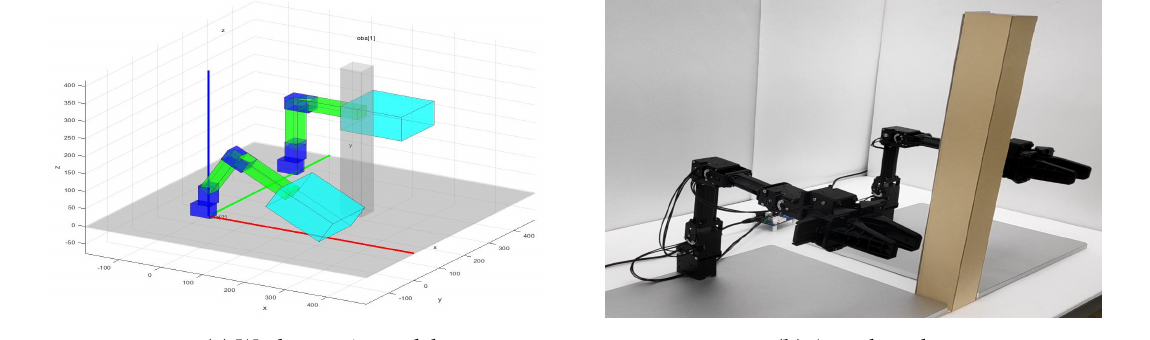
Figure 5. The workspace of